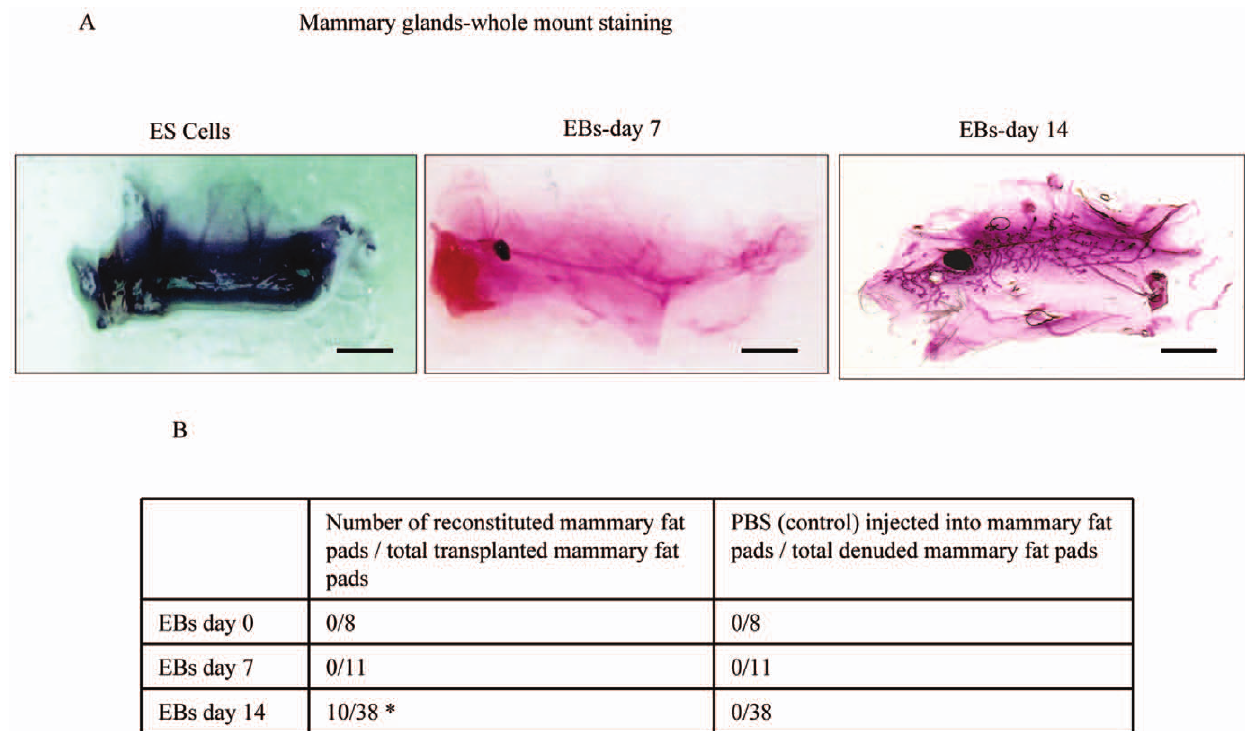
Figure 4. Reconstitution of mammary epithelium by mES cells. (A) Whole-mount staining of transplanted mammary glands. The 4 th mammary fat pad of 3 weeks old female mice were denuded and transplanted with either E14 mES cells, or EBs at day 7 or EBs at day 14, (ES cells were in-vitro differentiated in Methylcellulose into hematopoietic EBs at day 14 or at day 7), as indicated. Eight weeks after transplantation, whole- mount staining of the mammary fat pads were performed with carmine staining (magnification 2X, scale bar: 10 mm). (B) Virgin recipients harvested